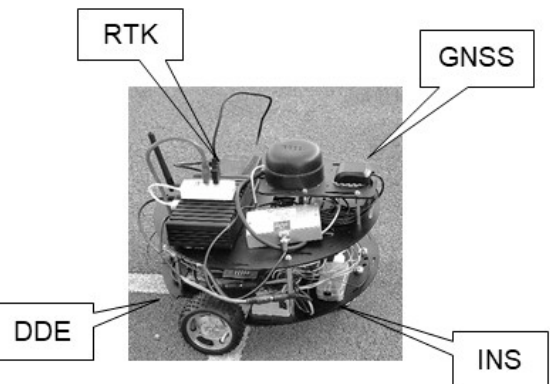
Figure 6. The mechanical structure and sensors of the QJ-Racecar.